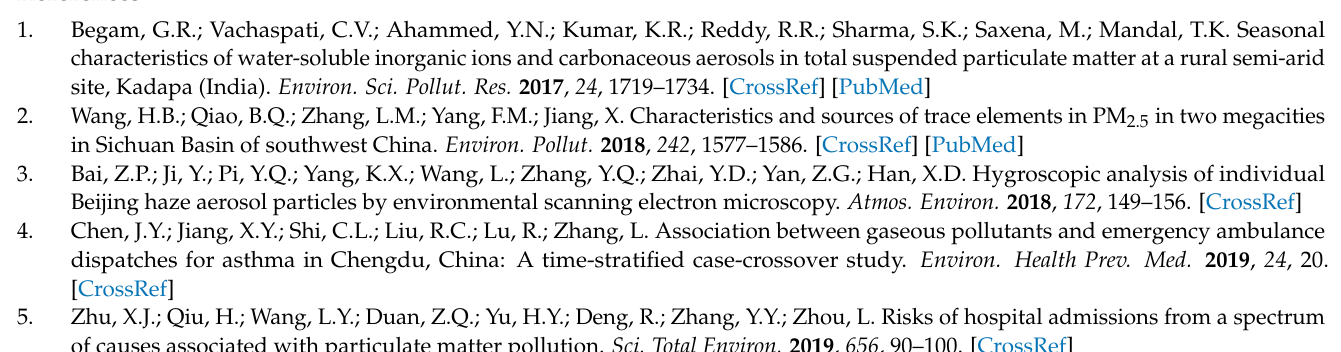
levels, Figure S2. Change in ions per particle at different pollution levels, Table S1: Average mass concentrations of heavy metals in PM 2.5 at different pollution levels (ng/m 3 ), Table S2: Average mass concentrations of heavy metals in PM 10 at different pollution levels (ng/m 3 ), Table S3: